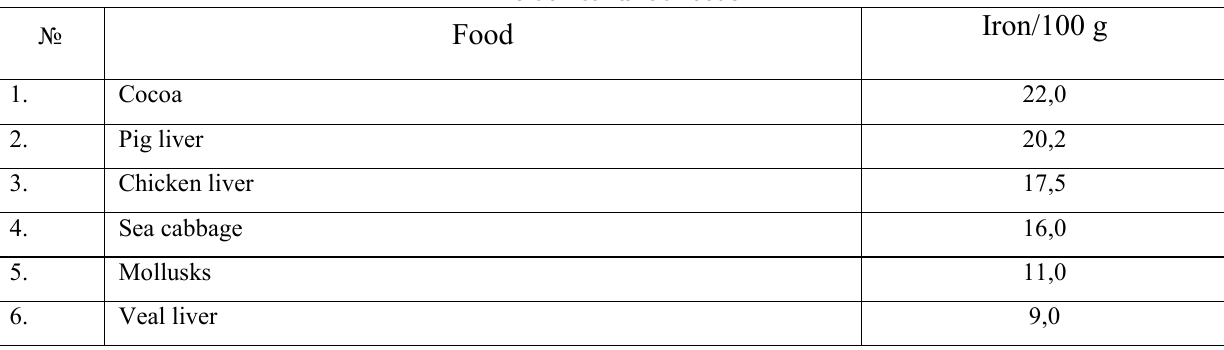
The iron content in